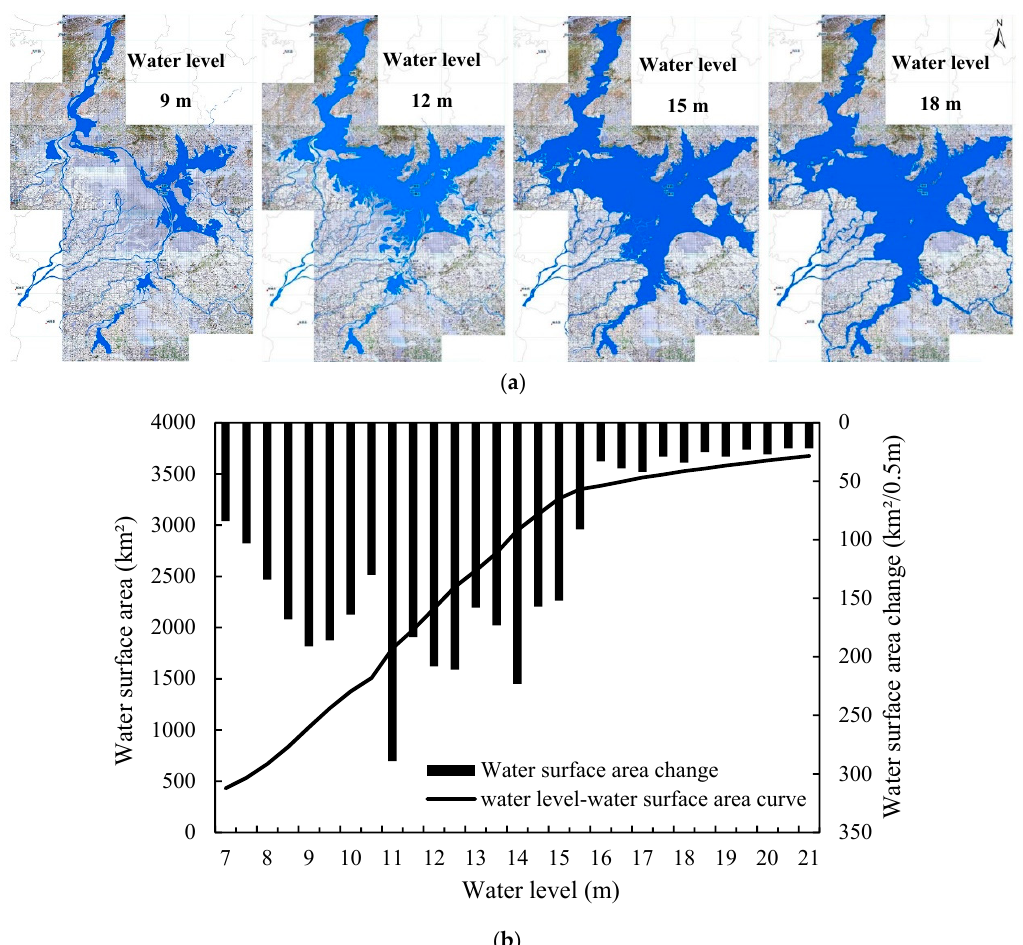
Figure 10. Relationship between water level and water surface area of Poyang Lake: ( a ) water surface area of Poyang Lake under different water levels, ( b ) water level–water surface area curve and the change rate of water surface area.